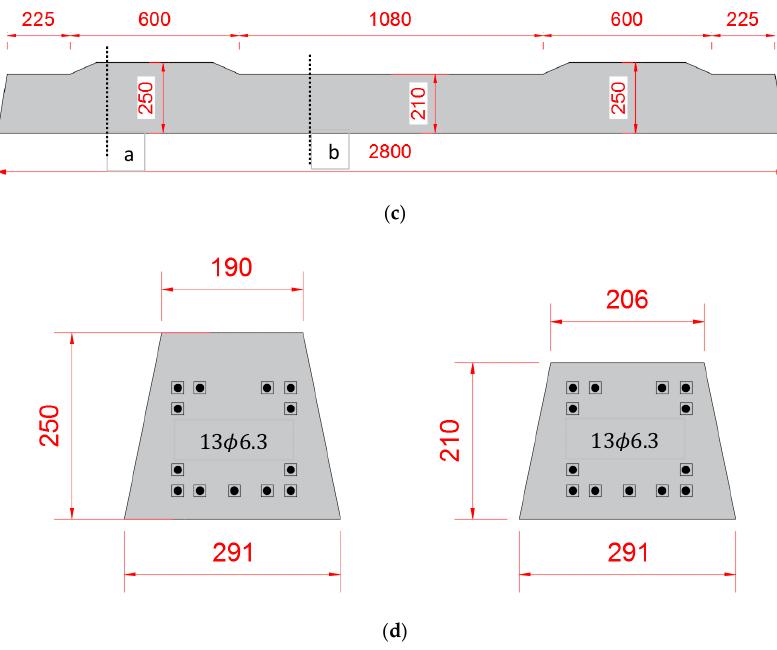
Figure 1. Detail of the geometry of the sleepers; ( a ) 3D view of the sleeper; ( b ) plan view; ( c ) side view; and ( d ) cross-section of the prestressed concrete sleeper.